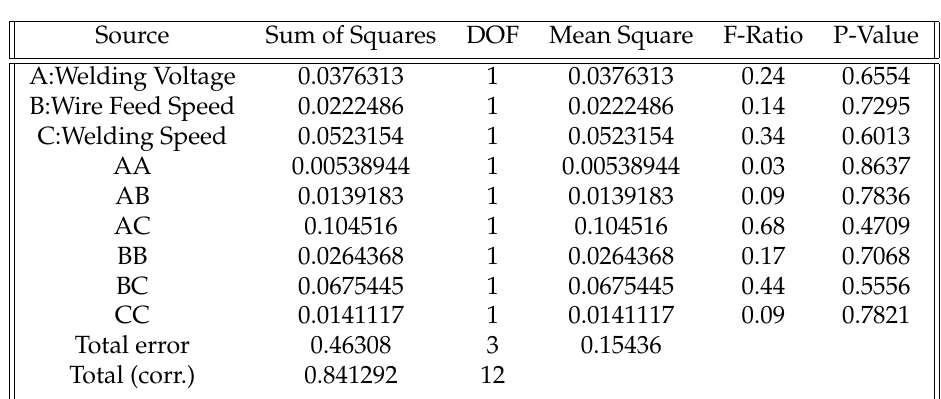
Figure 5. Pareto Chart for SQRT of Bead width Table 8. Variance’s analysis for SQRT of Weld